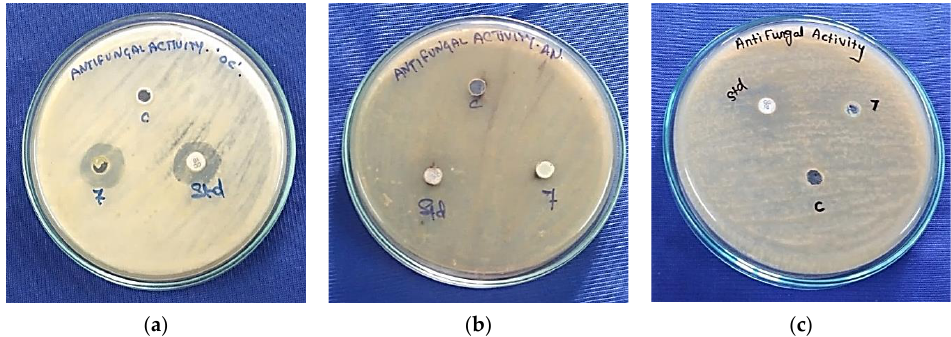
Figure 9. Antifungal activity of Ni 2+ -doped HApNPs treated against ( a ) O. caricae , ( b ) A. niger and ( c ) A. flavus. Table 2. Antifungal activity of Ni 2+ -doped HApNPs treated against fungal pathogens.